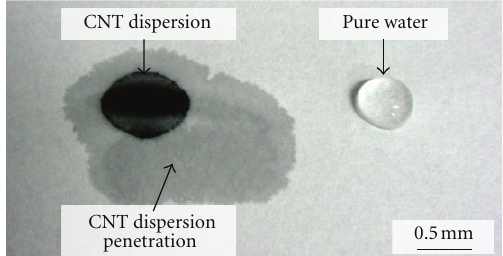
Figure 2: Appearance of CNT dispersion (left) and of pure water droplet (right) on paper 10 seconds after being dropped. CNT dispersion had penetrated the paper while pure water remained on the